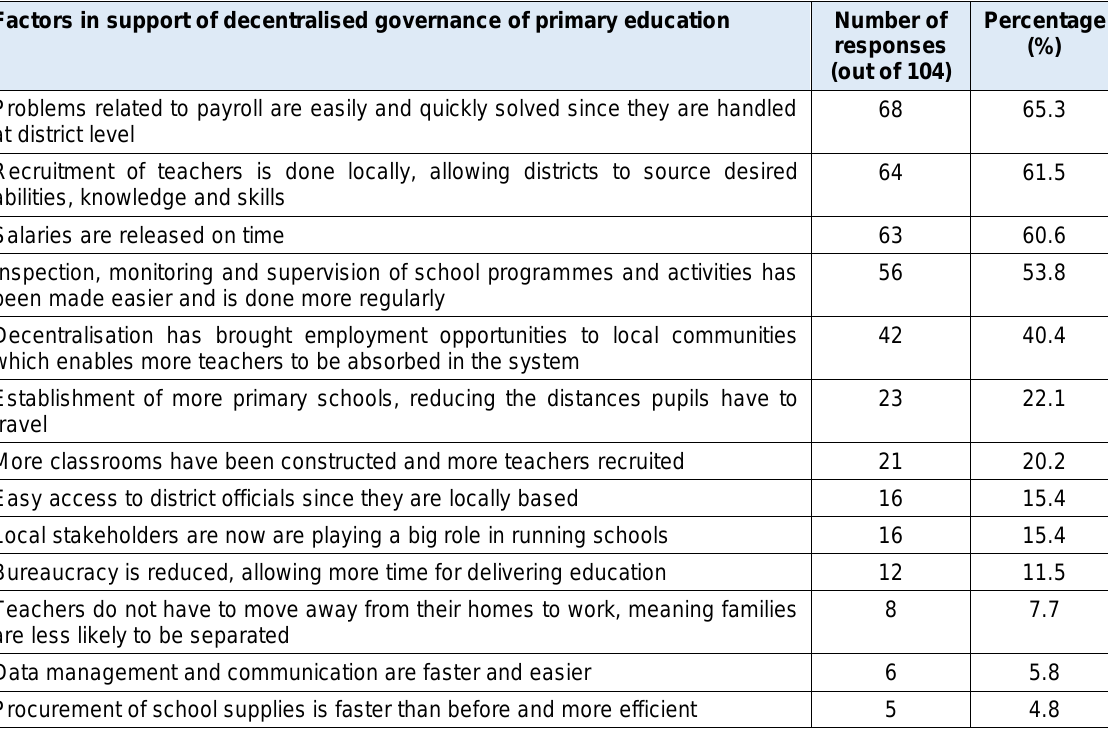
Table 4: Reasons for preferring decentralised governance, despite its